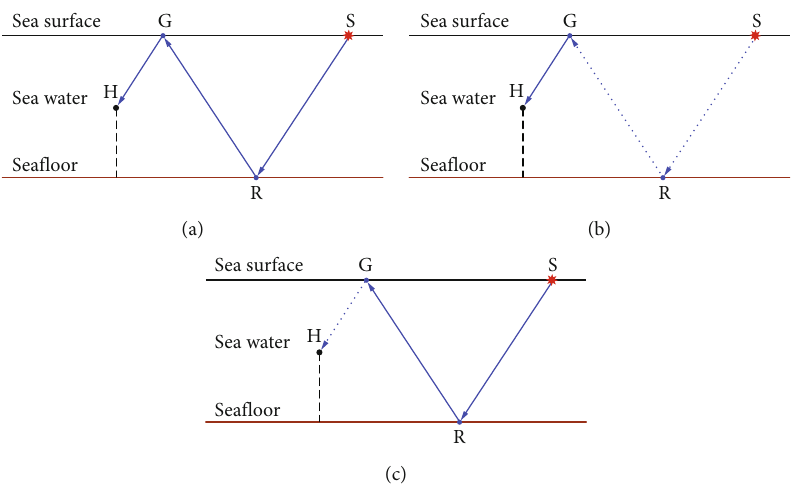
Figure 1: Cross-correlation of (a) a VCSP ghost wave with (b) a VCSP direct wave yields the SSP primary (c).